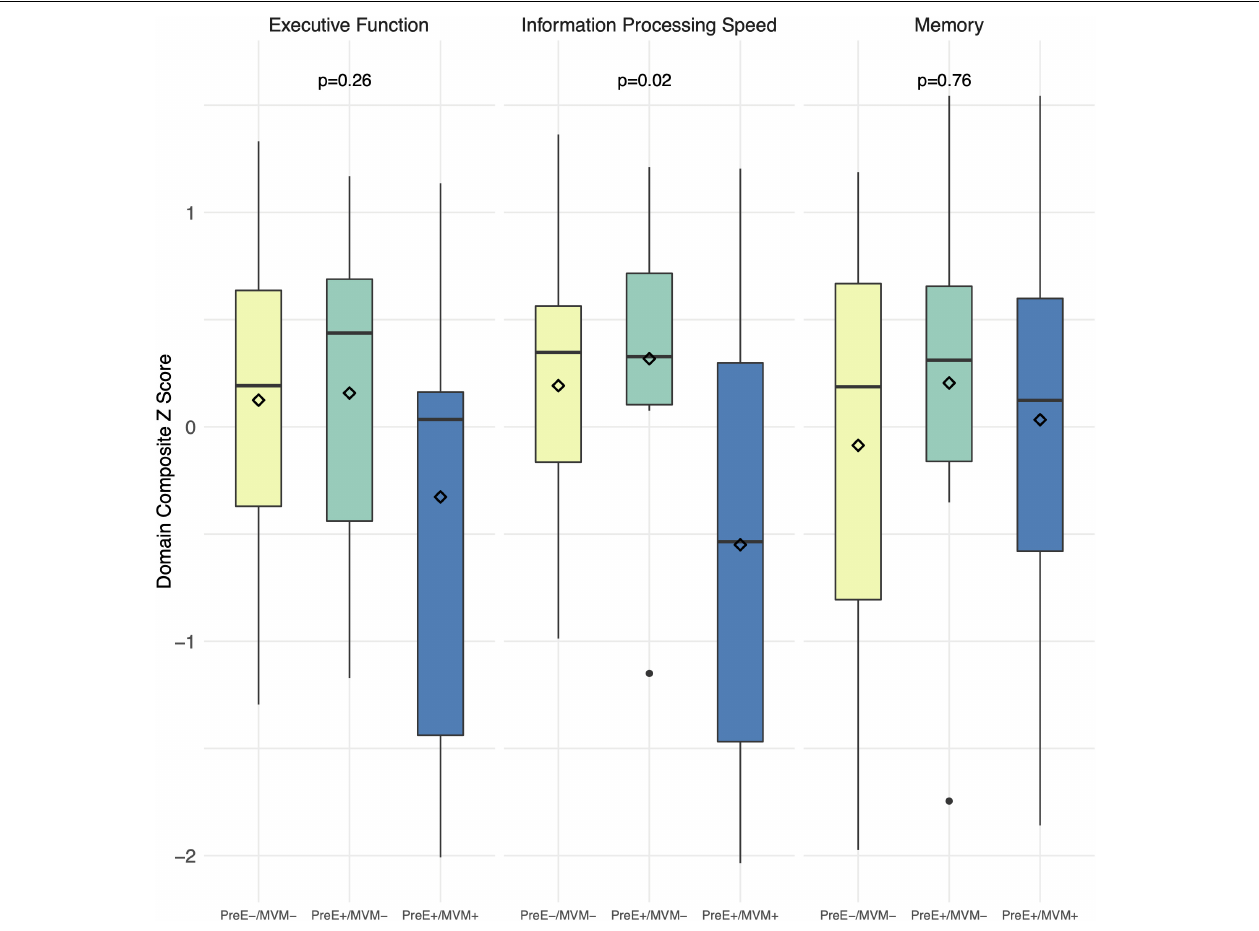
FIGURE 2 | Cognitive performance by preeclampsia and maternal vascular malperfusion status. Boxplots of unadjusted composite z -scores for each cognitive domain. Domain composite z -scores are average z -scores of the tests comprising the domain. Diamonds = mean score. P values are from ANOVAs. MVM, maternal vascular malperfusion; PreE,